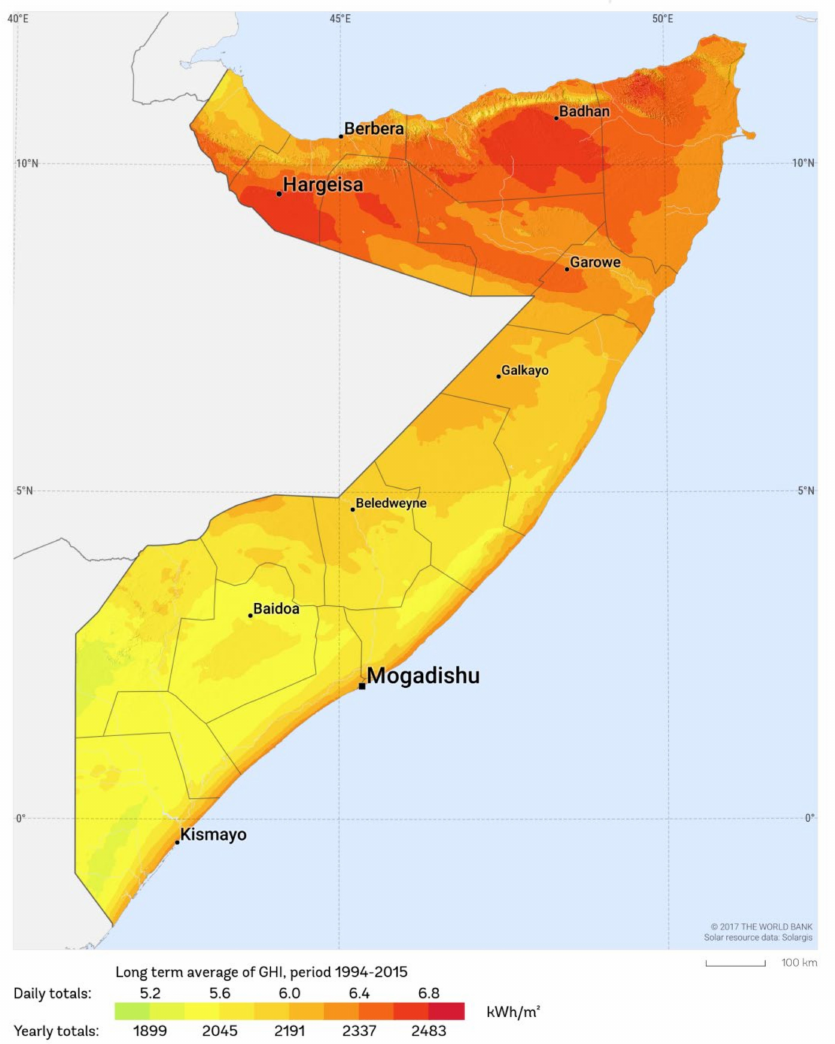
Figure 1. Solar radiation map of Somalia